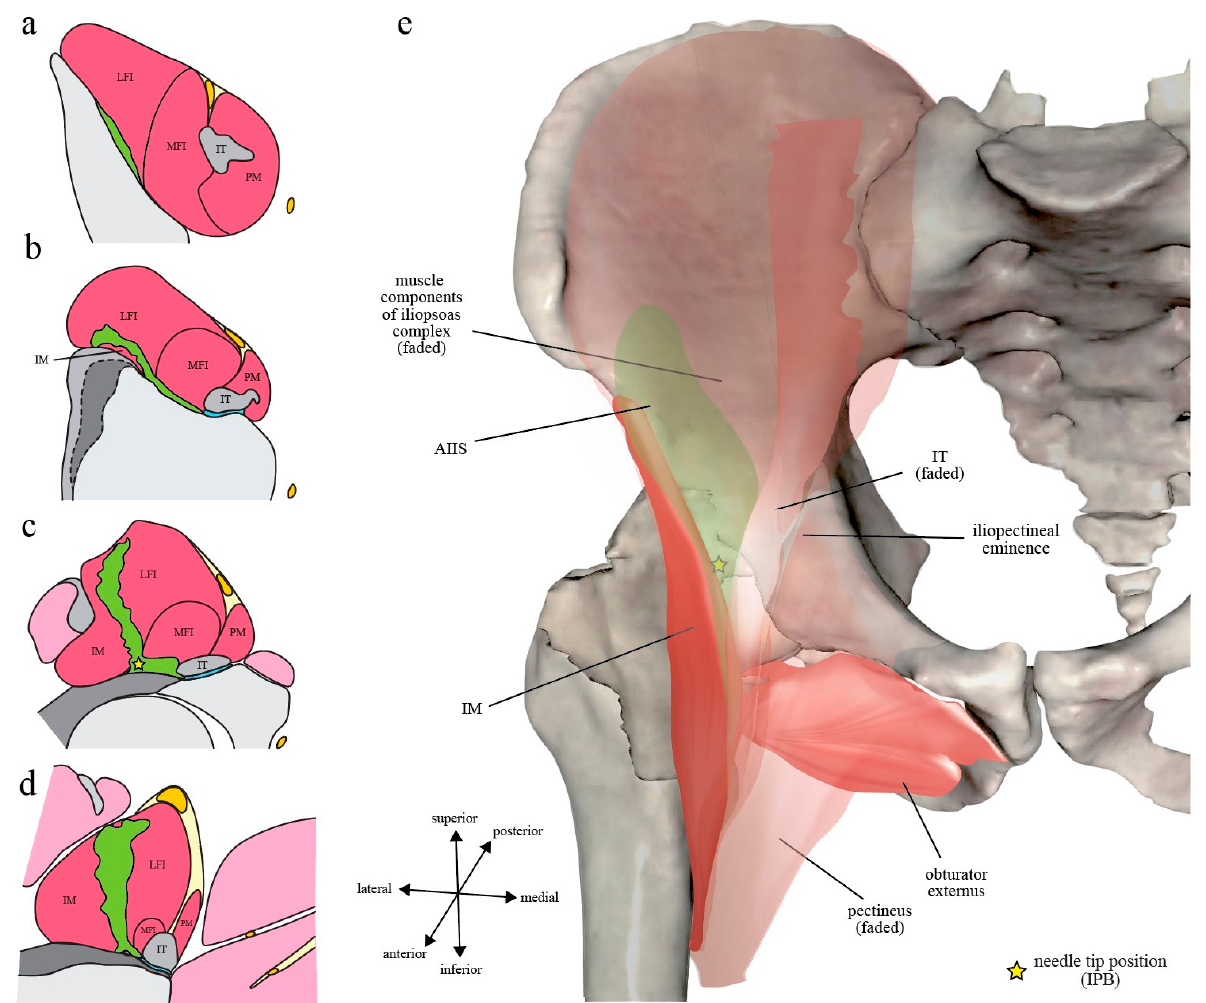
Figure 6. Injectate spread in living human subjects after iliopsoas plane block (IPB): ( a – d ) The most commonly observed pattern of injectate spread after 5 mL IPB, illustrated as the green-colored area, is superimposed on the four transverse section levels as depicted in Figure 1; ( e ) The injectate spread is colored in faded green and is overlayed by the iliopsoas complex to demonstrate its spatial relationship to iliacus minor (IM) and iliopsoas tendon (IT). Note that the injectate is confined within a well-defined iliopsoas plane (IP) without the extra-IP spread that is deep and medial to IT as in PENG block (Figure 5). However, there is superficial spread via the muscular IP towards fascia iliaca compartment (FIC) ( c , d ), potentially reaching femoral nerve proper when given higher volume of injection. The illustrated figure was made from an image acquired from the VH Dissector with permission from Touch of Life Technologies Inc. (www.toltech.net), based on the magnetic resonance images by Nielsen et al. [7]. The original image was reconstructed from real cadavers by the Visible Human Project ® of National Library of